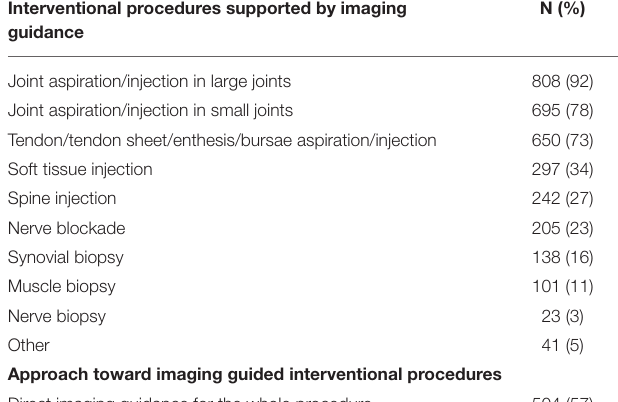
TABLE 2 | Number (percentage) of respondents reporting to perform one or more of the indicated procedures. Procedure